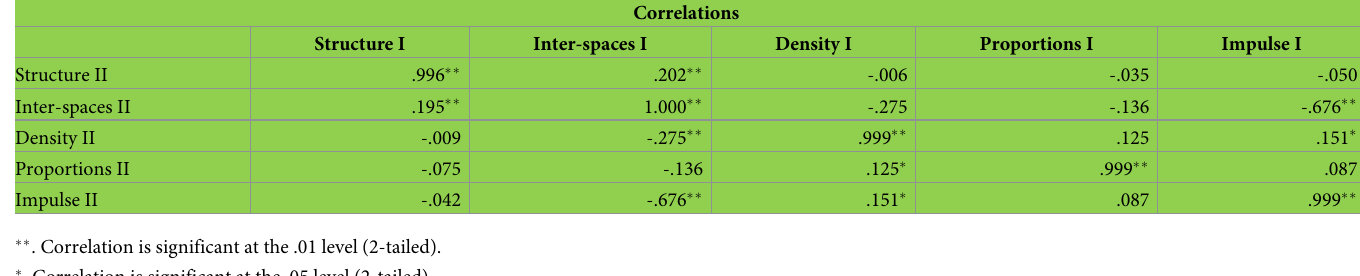
Table 6. Test-retest correlations: Correlations between 1st assessment and 2nd assessment (after four weeks) using the computer software.